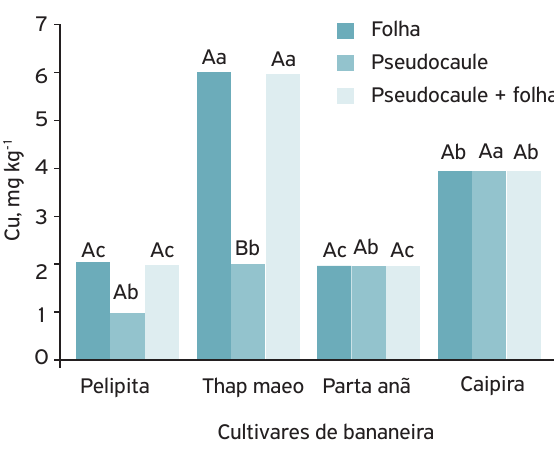
Figura 2. Teores de Cu, mg kg -1 , presente no substrato à base de resíduos de bananeira (pseudocaule, folha e pseudocaule + folha) de quatro cultivares de bananeira (Thap maeo, Prata anã, Pelipita e Caipira) antes de sua colonização pela linhagem 09/100 de Pleurotus ostreatus . Letras maiúsculas comparam médias dentro de um mesmo cultivar de bananeira; letras minúsculas comparam médias dentro de cada tipo de resíduo. Médias seguidas de letras iguais não diferem entre si (Tukey, 5%) (Média de duas